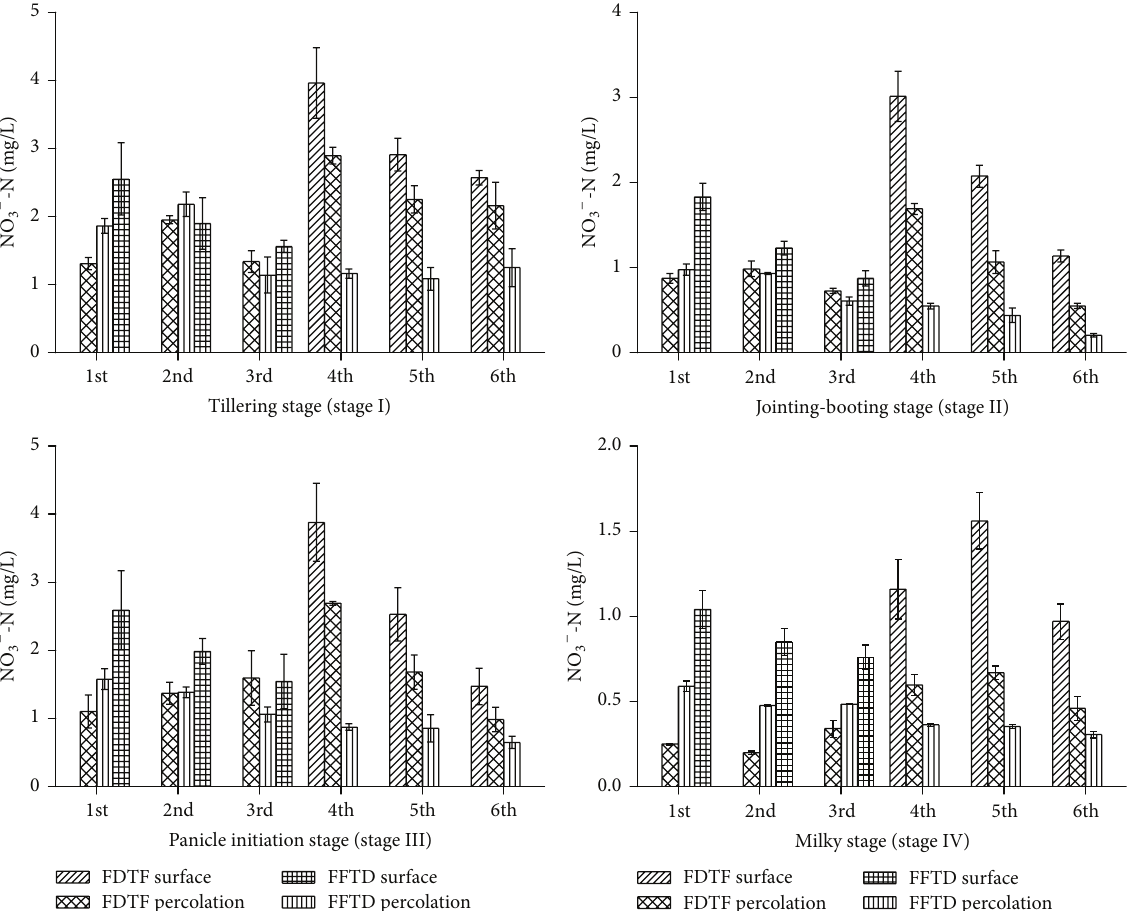
Figure 2: Change of NO 3− -N concentration at each stage. FDTF indicates first drought and then flooding; FFTD indicates first flooding and then drought. 1st, 2nd, and 3rd indicate the concentration on the first, third, and fifth day of flooding for the FFTD treatments and at the water level of 0mm, − 250 mm, and − 500 mm for the FDTF treatments. 4th, 5th, and 6th indicate the concentration on the first, third, and fifth day of flooding for the FDTF treatments and at the water level of 0mm, − 250 mm, and − 500mm for the FFTD treatments. Vertical bars represent standard error of the